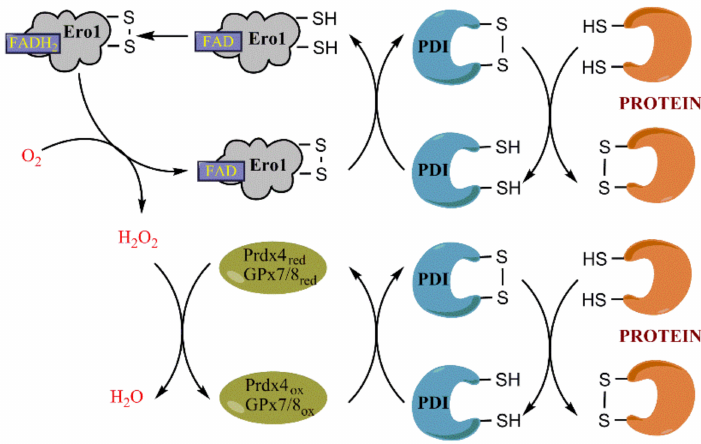
Figure 4. Role of ER oxidoreductin 1 (Ero1), peroxiredoxin 4 (Prdx4) and glutathione peroxidases (GPx) 7 and 8 in oxidative protein folding. The primary oxidative equivalents are generated by a FAD-dependent enzyme Ero1 that reduces molecular oxygen (O 2 ) into hydrogen peroxide (H 2 O 2 ). It leads to formation of a disulfide bond between two cysteines of Ero1 followed by a disulfide-dithiol exchange with a protein disulfide isomerases (PDI) and later with the target protein. Noteworthy, the figure does not show exchanges between several pairs of cysteines within Ero1. The generated H 2 O 2 is utilized by Prdx4 or GPx7/8, that also oxidize PDI. Thus, a reduction of one oxygen molecule generates equivalents for oxidation of two pairs of cysteines of a target